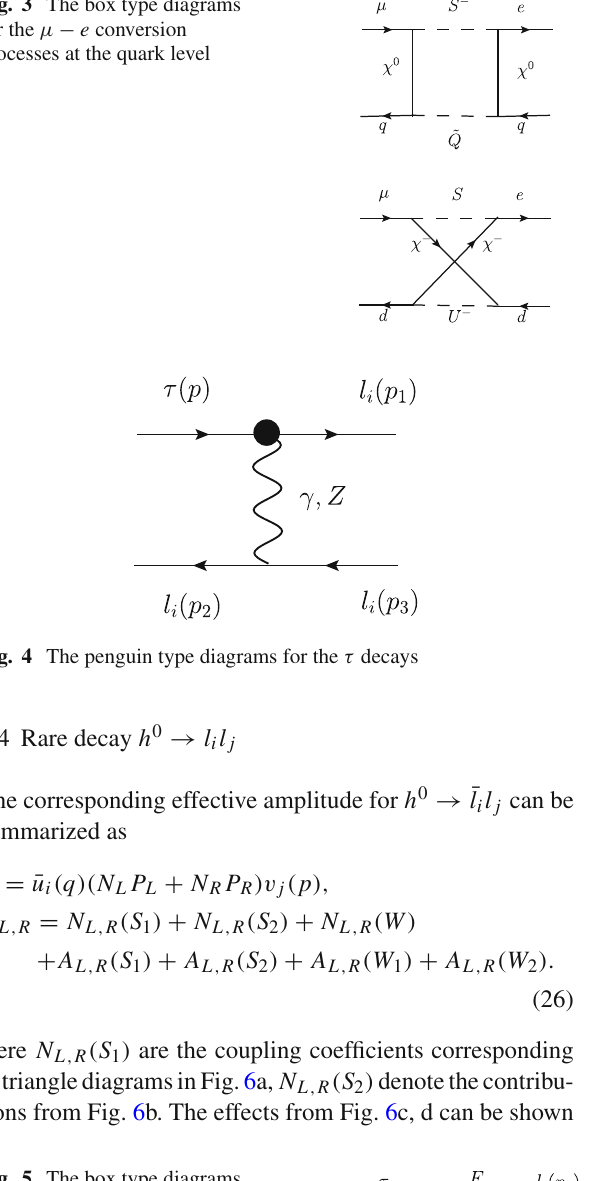
Fig. 5 The box type diagrams for the τ